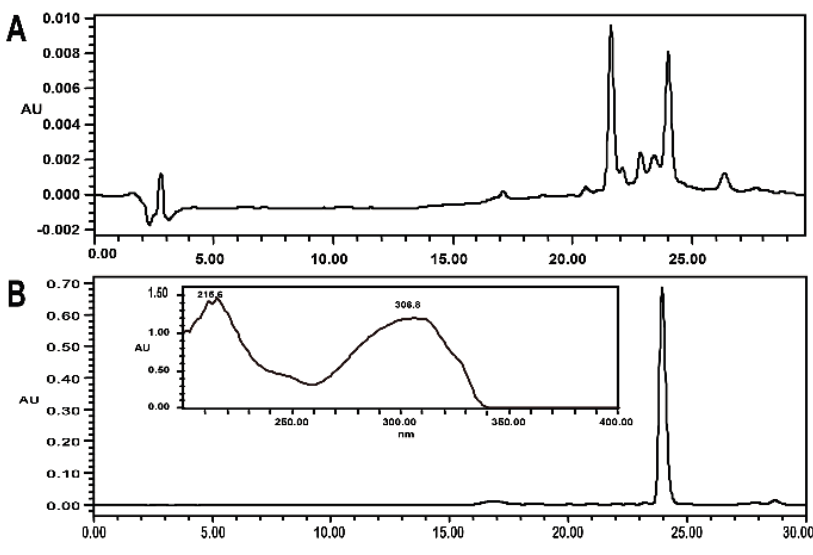
Figure 2. HPLC chromatogram of the fraction containing the peak 12 ( A ); HPLC chromatogram and UV spectrum of the peak 12 ( B